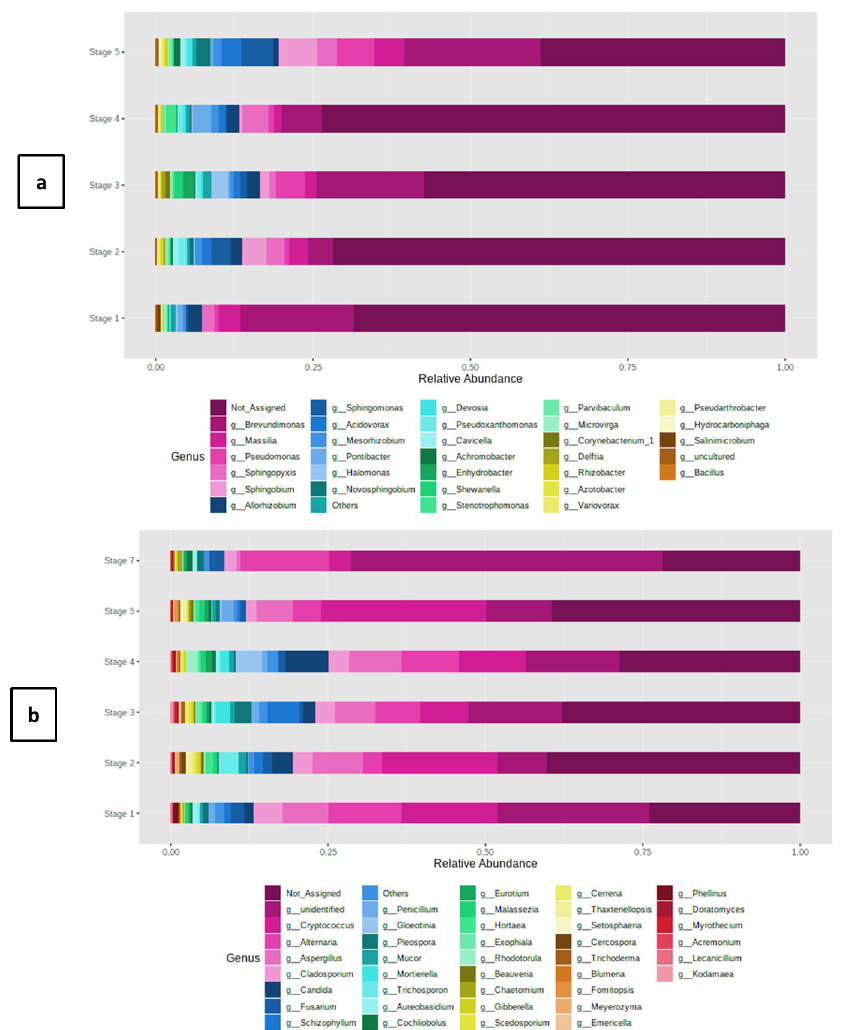
Fig 9. Relative abundance of (a) bacterial and (b) fungal genus associated with different size fractions of dust at the remote and urban sites. Bacterial genera were only found in the respirable fractions (stage 1–5). Fungal genera were detected both in respirable (stage 1–5) as well as in the inhalable (stage 7) size fraction of